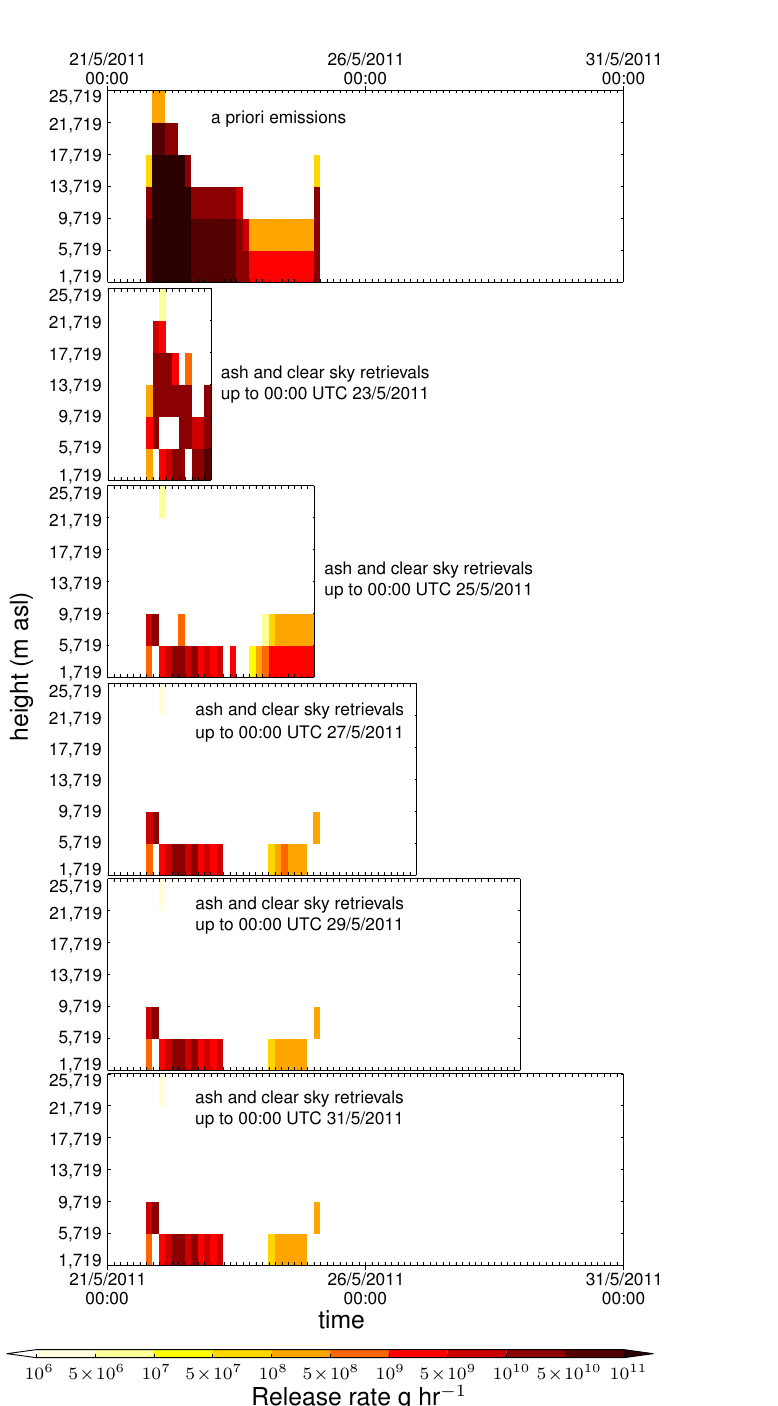
Figure 9. As Figure 8 but using ash and clear sky satellite retrievals.